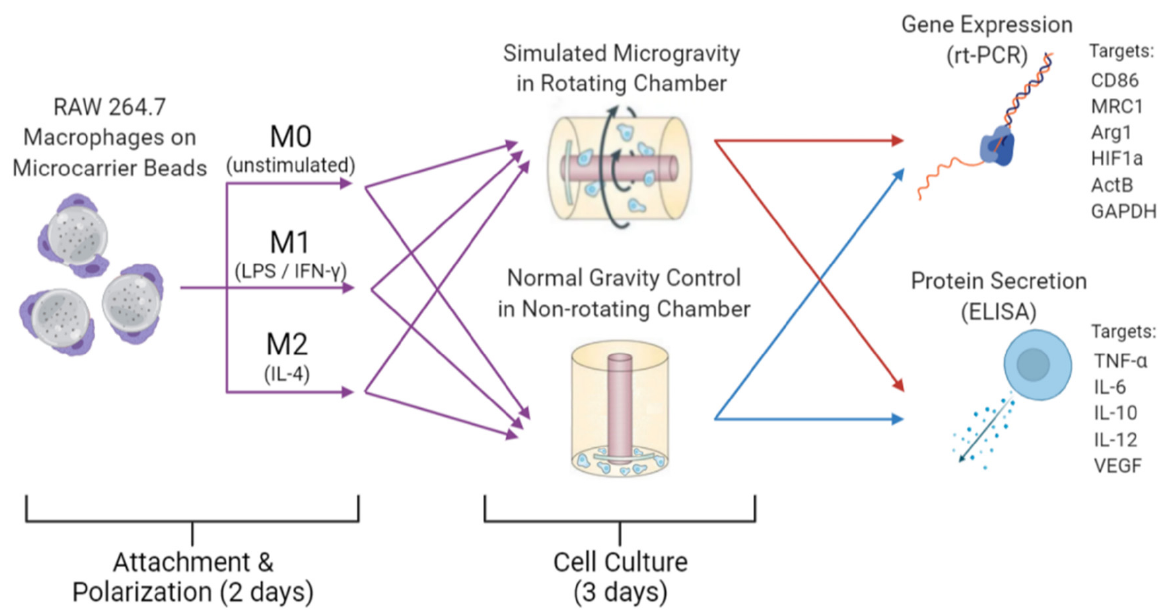
Figure 1. Visual schematic of experimental design. Purple arrows indicate preparations of cells prior to RWV culture for all three phenotypes. Red and blue arrows indicate simulated µG samples and control 1G samples, respectively, were analyzed via RT-PCR and ELISA subsequent to 3 days of cell culture under their respective conditions. Created with